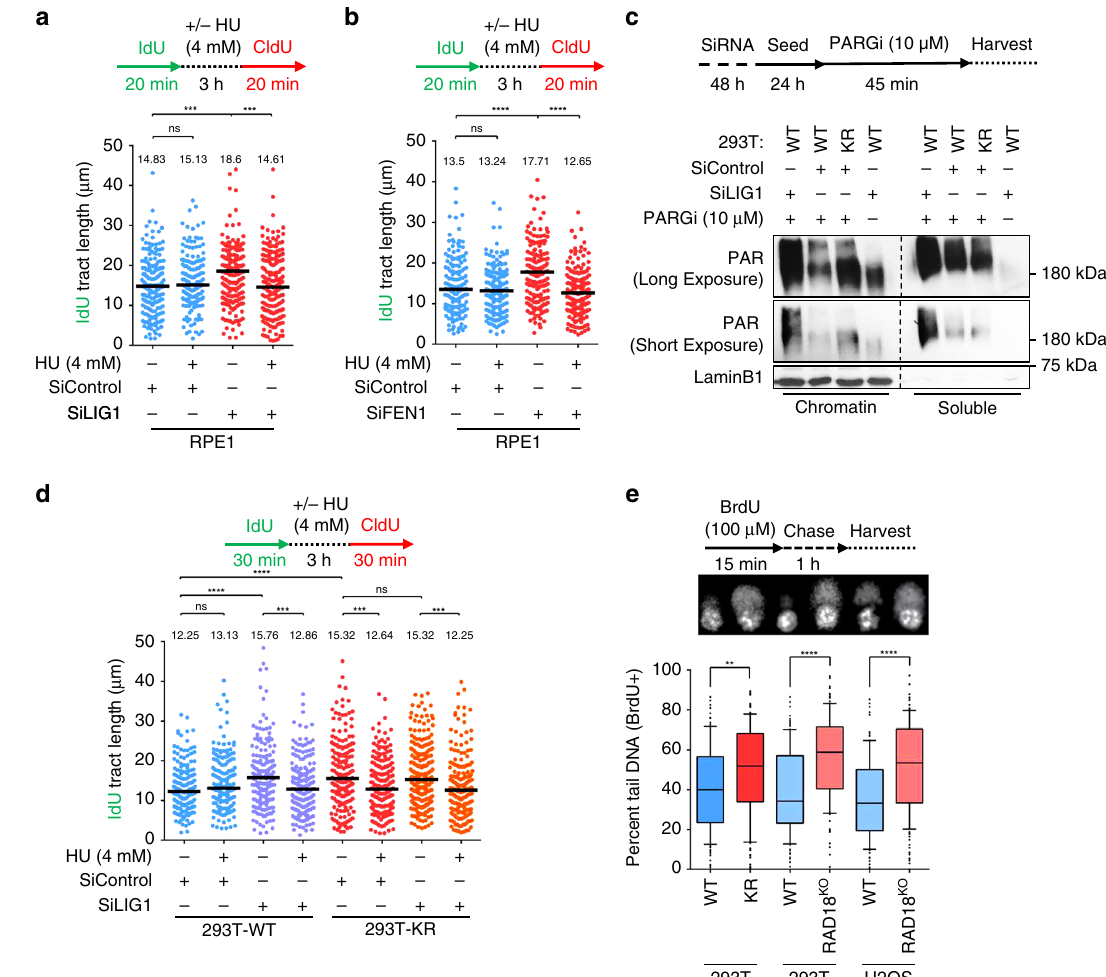
Fig. 4 Defective Okazaki fragment maturation results in nascent strand degradation. a , b DNA fi ber combing assays showing that depletion of LIG1 a or FEN1 b results in faster replication fork progression under normal conditions, and induce nascent strand degradation upon fork arrest. The quanti fi cation of the IdU tract length is presented, with the median values marked on the graph and listed at the top. Asterisks indicate statistical signi fi cance (Mann – Whitney test, two-sided). Schematic representations of the assay conditions are also presented. Western blots con fi rming the knockdowns are shown in Supplementary Fig. 6a. c Chromatin fractionation experiment showing increased PAR chain formation in KR cells under normal growth conditions, indicative of defective Okazaki fragment maturation. Cells were treated as indicated with a PARG inhibitor (PARGi) for 45 min prior to harvesting to block PAR chain removal. LIG1 depletion was used as positive control for defective Okazaki fragment maturation. Chromatin-associated LaminB1 was used as loading control. d Loss of LIG1 is epistatic with the PCNA-K164R mutation for fork progression and HU-induced nascent strand degradation in 293T cells. The quanti fi cation of the IdU tract length is presented, with the median values marked on the graph and listed at the top. Asterisks indicate statistical signi fi cance (Mann – Whitney test, two-sided). A schematic representation of the assay conditions is also presented. Similar results for LIG1 and FEN1 depletion in RPE1 cells are presented in Supplementary Fig. 6c, d. e BrdU-alkaline comet assay showing accumulation of ssDNA gaps under normal replication conditions in 293T-K164R and RAD18-knockout 293T and U2OS cells. At least 100 cells were quanti fi ed for each condition. Center line indicates the median, bounds of box indicate the fi rst and third quartile, and whiskers indicate the 10th and 90th percentile. Asterisks indicate statistical signi fi cance ( t -test, two-tailed, unequal variance). A schematic representation of the assay conditions, and representative micrographs, are also presented. Western blots con fi rming RAD18 knockout, and presenting the levels of PCNA ubiquitination in these cells, are shown in Supplementary Fig. 6e, f. Source data are provided as a Source Data fi